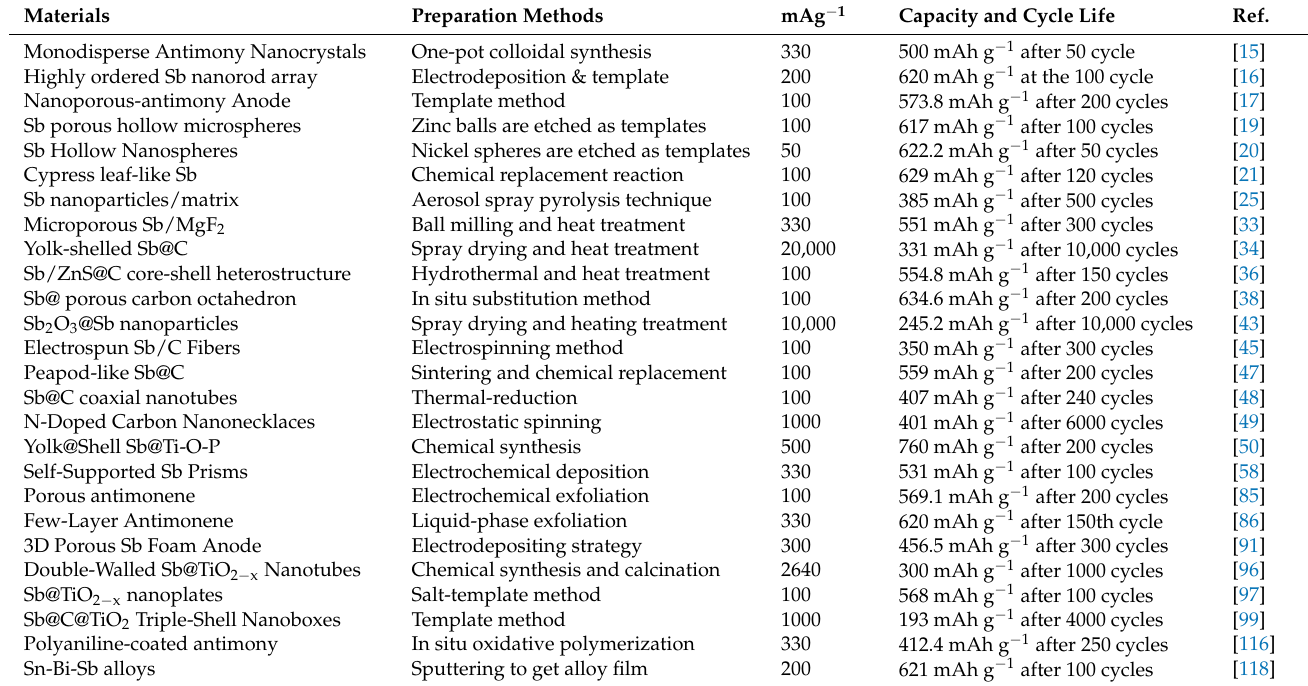
Table 1. Structure preparation and electrochemical properties of different antimony based materials. (mAg − 1 represents current